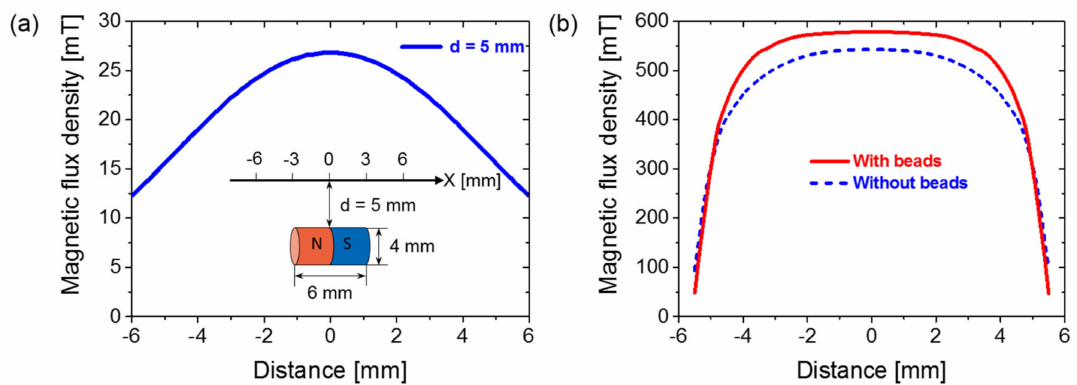
Figure 7. Simulation results of the magnetic flux density in the air and the Wiegand wire: ( a ) in the air and ( b ) in the Wiegand wire.